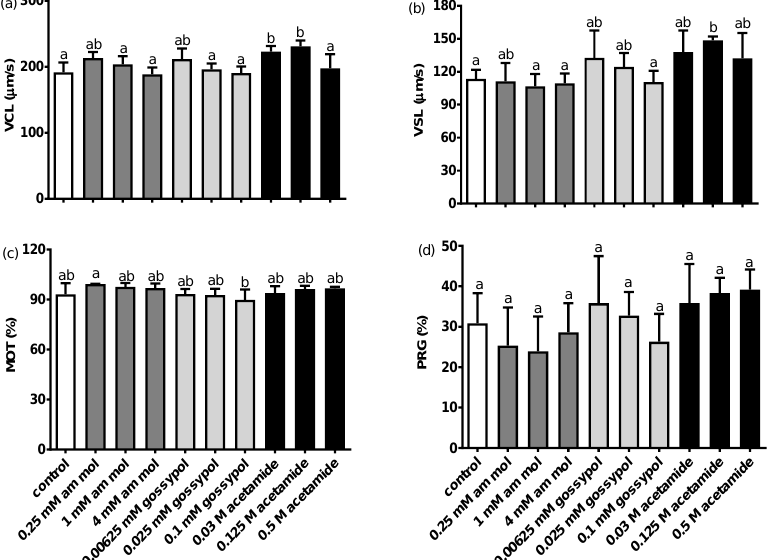
Figure 3. The effect of the enzyme inhibitors added to spermatozoa on the perch sperm motility parameters: ( a ) VCL, curvilinear velocity of sperm, ( b ) VSL, straight-line velocity, ( c ) MOT, motile sperm and ( d ) PRG, progressive sperm. Values are shown as a mean ± SD, p ≤ 0.01, n = 4. Different letters (a, b) indicate the statistically significant differences between the doses of inhibitors ( p ≤ 0.01). The data were analysed using a repeated measure one-way analysis of variance (ANOVA), followed by Tukey’s post hoc test.